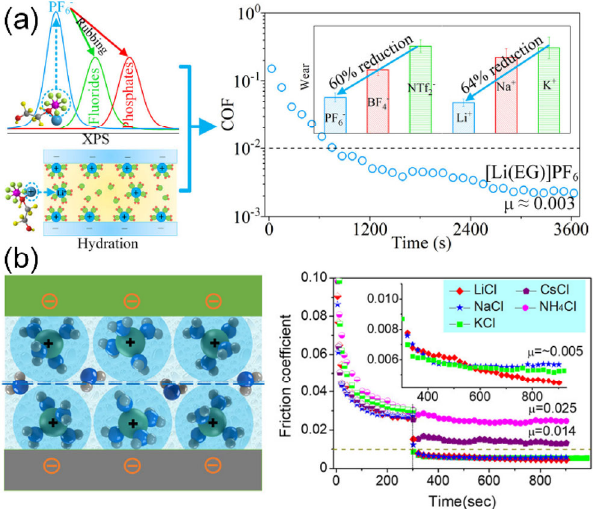
Fig. 5 (a) [Li(EG)]PF 6 can provide the best superlubricity among other combinations of anions and cations, because Li + is the smallest and PF 6 − can transform into phosphates. Reproduced with permission from Ref. [55]. © American Chemical Society, 2019. (b) Superlubricity obtained by hydrated alkali metal